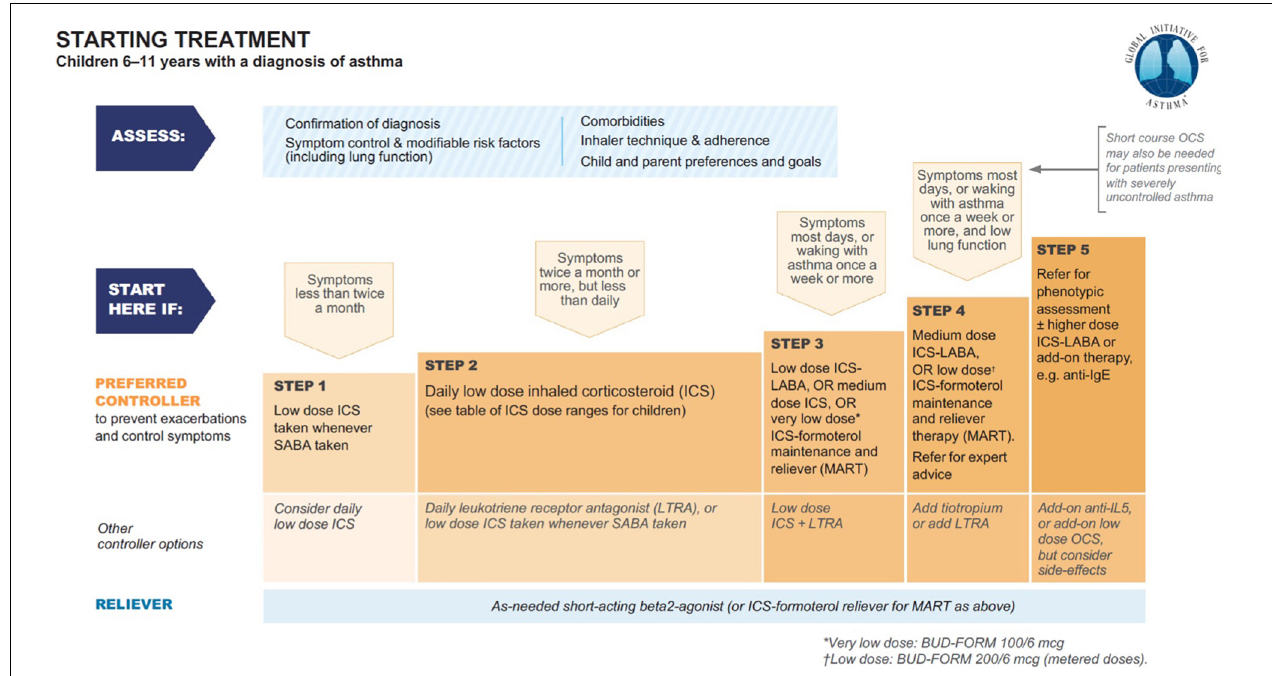
FIGURE 1 | Asthma treatment from GINA 2021 guideline main report